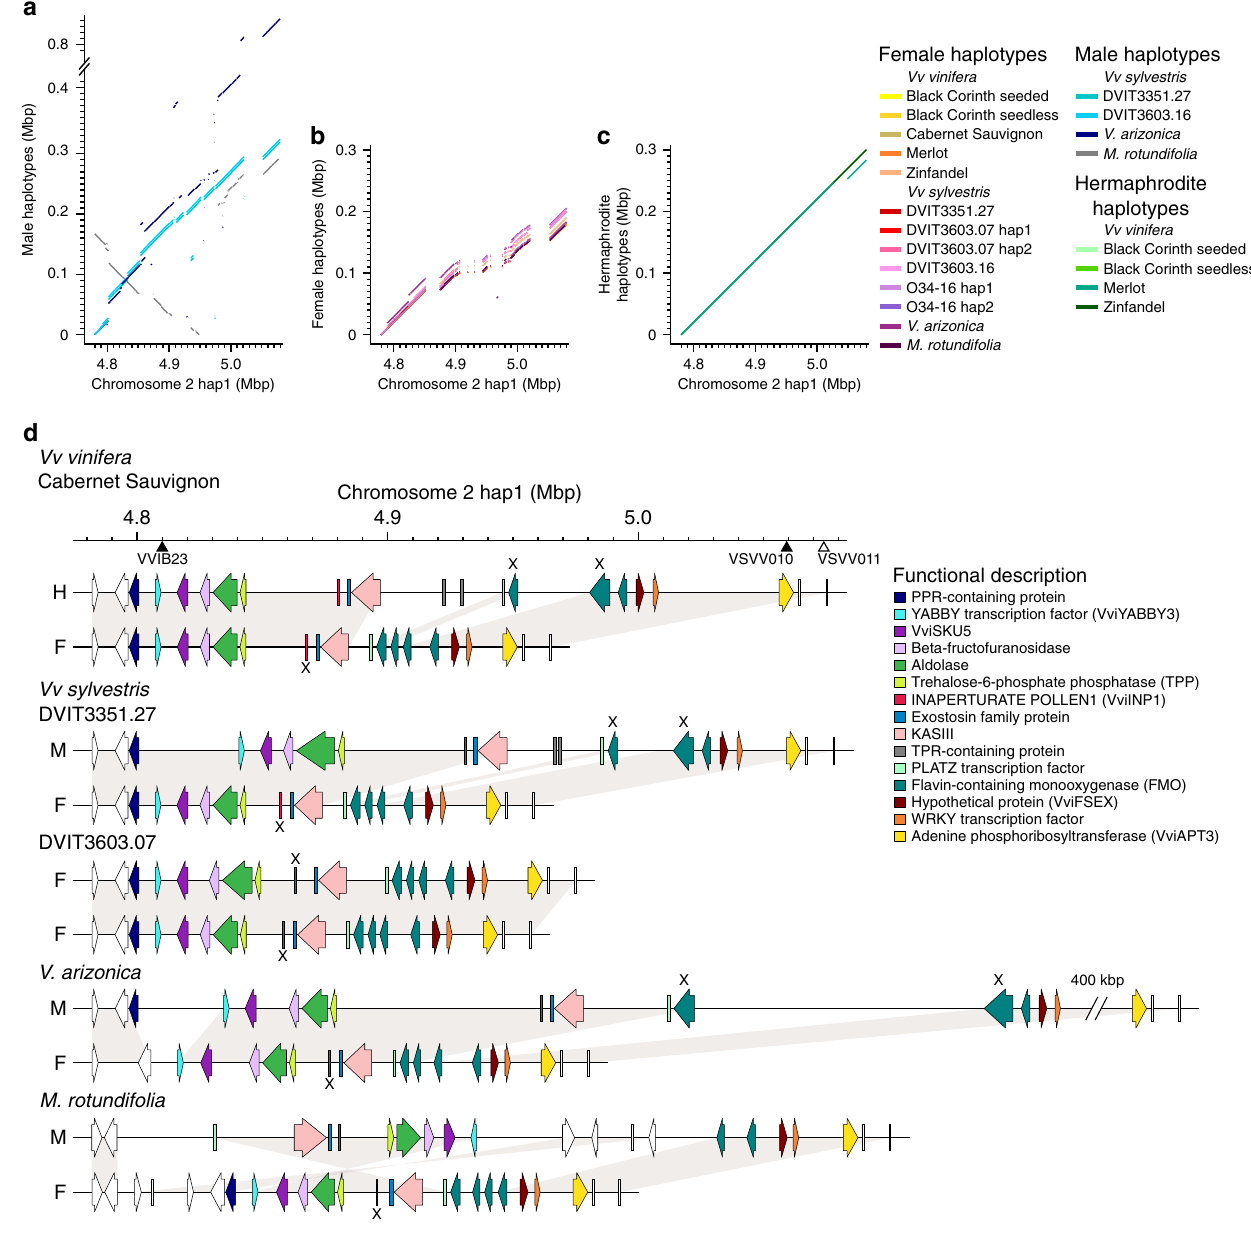
Fig. 2 Sex-linked structural variants and their impact on gene content. Whole-sequence alignments of the sex-determining region (SDR) in M ( a ), F ( b ), and H ( c ) haplotypes against the Vv vinifera Cabernet Sauvignon chromosome 2 hap1 (H) reference. The fi gures illustrate that M haplotypes ( a ) tend to be longer than either F ( b ) or H ( c ) haplotypes and there is a large inversion in the M haplotype of M. rotundifolia . d Schematic representations of the SDR in four of the 11 genomes analyzed for this study. From top to bottom, the fi gure illustrates the haplotypes of hermaphrodite Vv vinifera Cabernet Sauvignon (HF), male Vv sylvestris DVIT3351.27 (MF), female Vv sylvestris DVIT3603.07 (FF), male V. arizonica (MF), and male M. rotundifolia (MF). Each haplotype is annotated with arrows and rectangles to depict annotated genes. White arrows depict genes that are not sex-linked. Genes affected by nonsense mutations are indicated with an X. The scale above the haplotypes denotes the position on the Cabernet Sauvignon reference. The fi lled, black triangles on this scale mark the position of the sex-linked genetic markers VVIB23 17 and VSVV010 10 ; the white- fi lled triangle represents the amplicon VSVV011 10 , which is not linked to the SDR. Source data are provided as a Source Data fi fi rst FMO-coding gene, which introduced a premature stop codon Vitis and Muscadinia diverged and is therefore likely to be in H and M alleles, and (ii) an 8 bp INDEL in the grape ortholog widespread in Vitis . Phylogenetic analysis of the INP1 protein of the A. thaliana INP1 (AT4G22600), which caused a frameshift clustered Vitis and Muscadini a orthologs by sex, con fi rming the and premature stop codon in all F alleles (Fig. 4a). The 8 bp sex-speci fi city of INP1 alleles (Fig. 4b; Supplementary Fig. 5). INDEL in F VviINP1 alleles leads to the truncation of the protein The sex-speci fi city of INP1 alleles provided an opportunity to to 41 amino acids (228 amino acids in H/M haplotypes). Because estimate the divergence date between M and F haplotypes and the same 8 bp deletion was also found in the F haplotype of M. hence the potential age of dioecy. We calculated the average rotundifolia (Fig. 4a), this F-speci fi c INDEL likely occurred before synonymous distance (dS) between all 52 pairs of F and M alleles